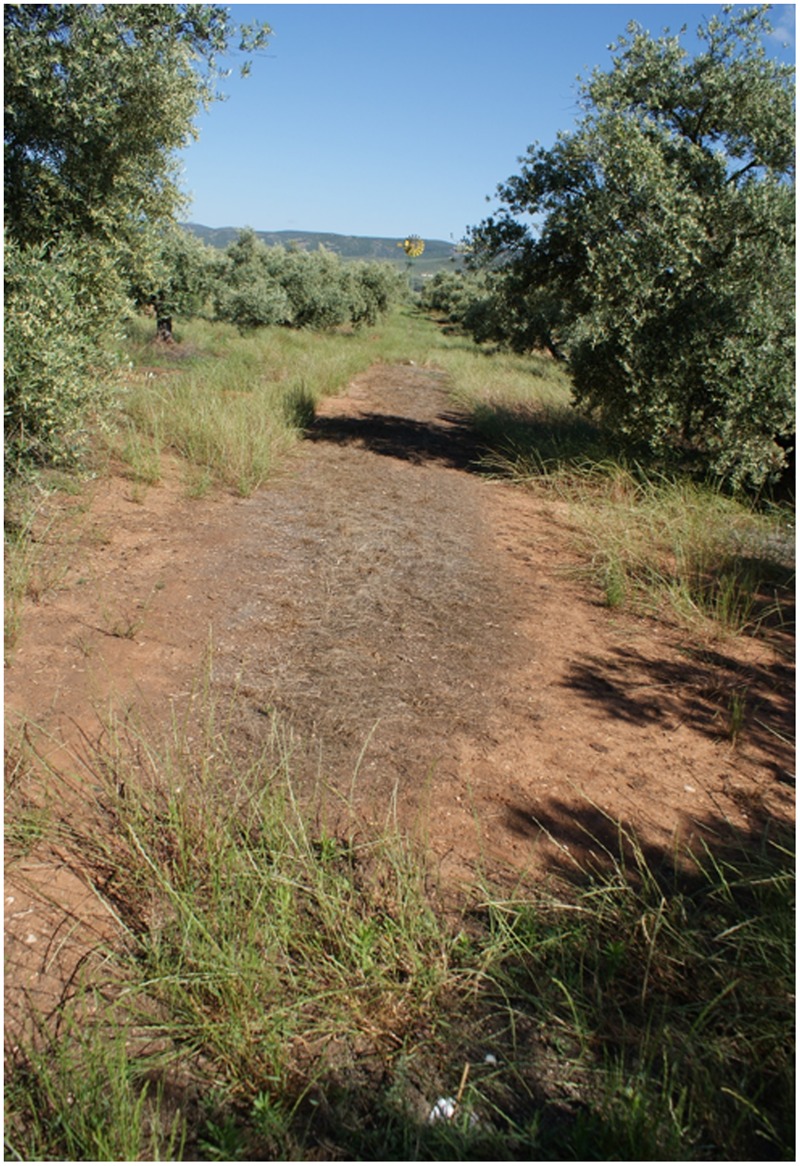
Rigid ryegrass treated with 50 g ai ha-1 (grams of active ingredient per hectare) + 1800 g ae ha-1 (grams of acid equivalent per hectare) of flazasulfuron and glyphosate at early post-emergence and measured 60 days after treatment.